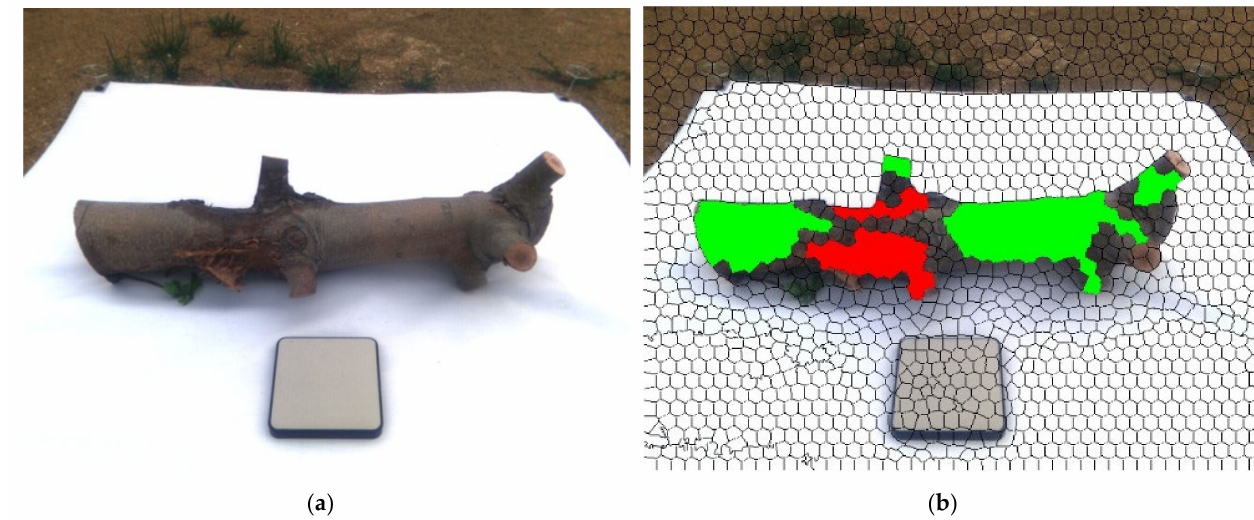
Figure 2. ( a ) A composite color image created from the hyperspectral imaging of an apple tree trunk; ( b ) Superpixel segmentation and manual labeling. Superpixels corresponding to healthy and diseased areas are indicated by green and red colors,